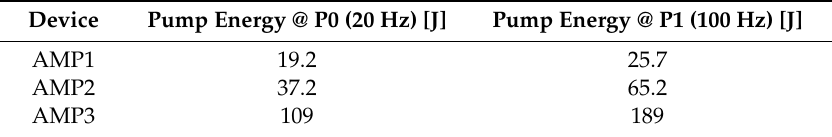
Table 3. Pump energy requirements for the various amplification